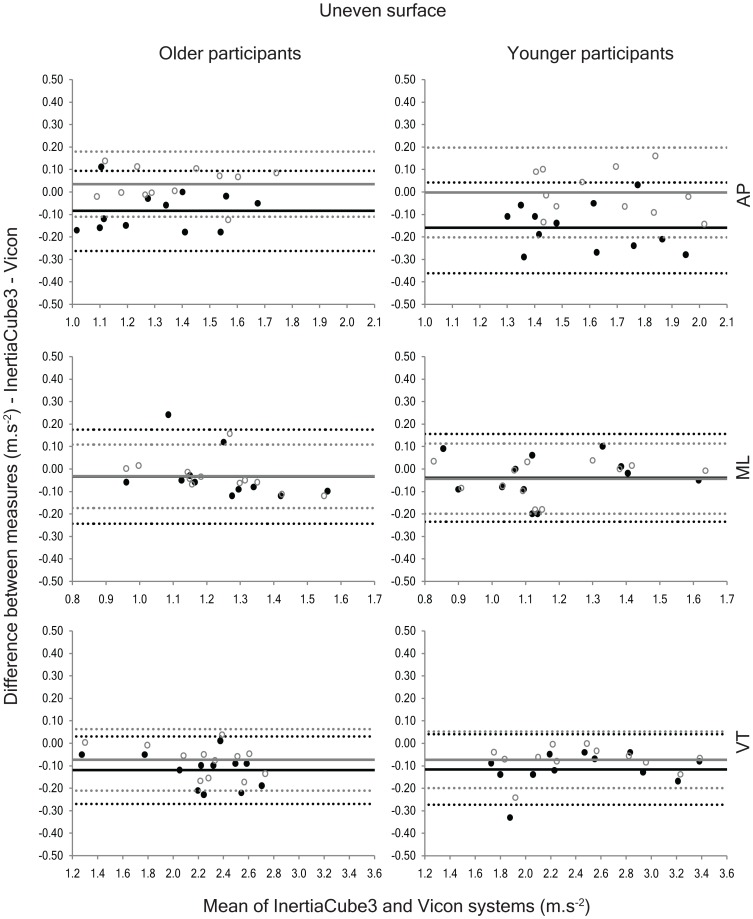
Bland-Altman plots depicting the agreement between the anteroposterior (AP), mediolateral (ML) and vertical (VT) accelerations collected using the InertiaCube3 and Vicon systems while walking on the uneven surface.The solid black circles represent the agreement between the two instruments using the detrending method and the open grey circles show the agreement using the quaternion method. The solid lines represent the systematic bias between the two measures and the dashed lines indicate the 95% limits of agreement (black = detrending method; grey = quaternion method).